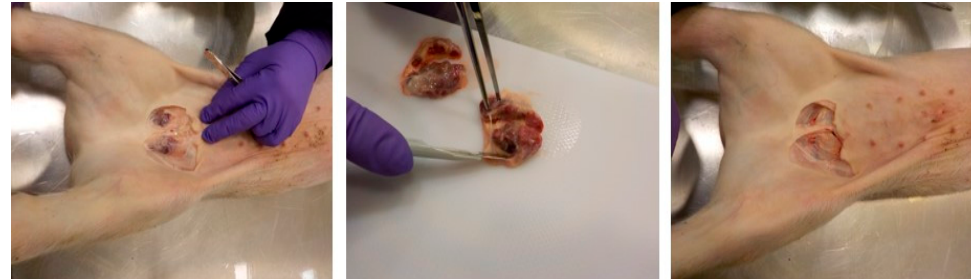
Figure 1. Superficial inguinal lymph nodes are a quickly collectable sample type in pigs with no/minimal bloodshed or full post mortem examination.